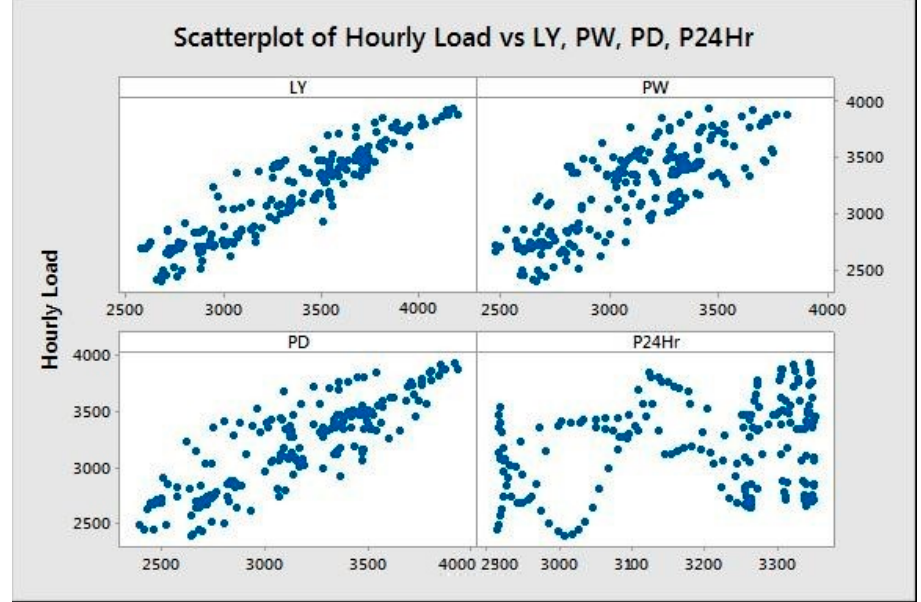
Figure 8. The relationships between the hourly load and the independent variables LY, PW, PD,